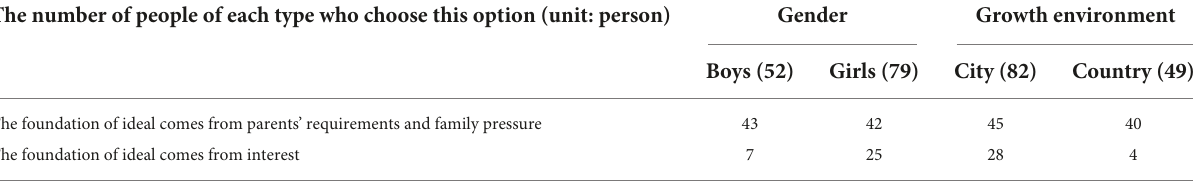
TABLE 8 Intra group comparative data on ideals and beliefs of college students from divorced families. The number of people of each type who choose this option (unit: person)